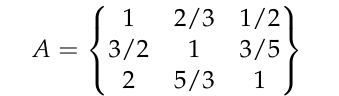
Table 6. Relationship of the importance of three evaluation factors of dynamic obstacle avoidance. A 1 A 2 A 3 A 1 1 2/3 1/2 A 2 3/2 1 3/5 A 3 2 5/3